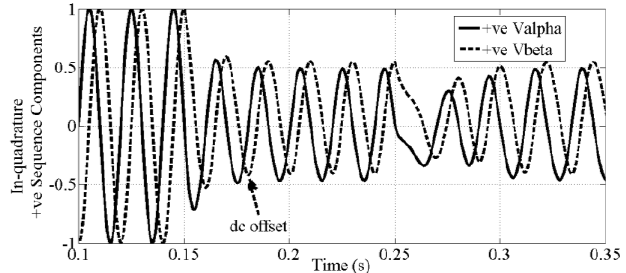
Fig. 2. Output waveform of in-quadrature ( 𝑣 𝛼+ and𝑣 𝛽+ ) positive sequence components in presence of dc offset and frequency jump in the sensed input signal of standard SOGI-QSGs.